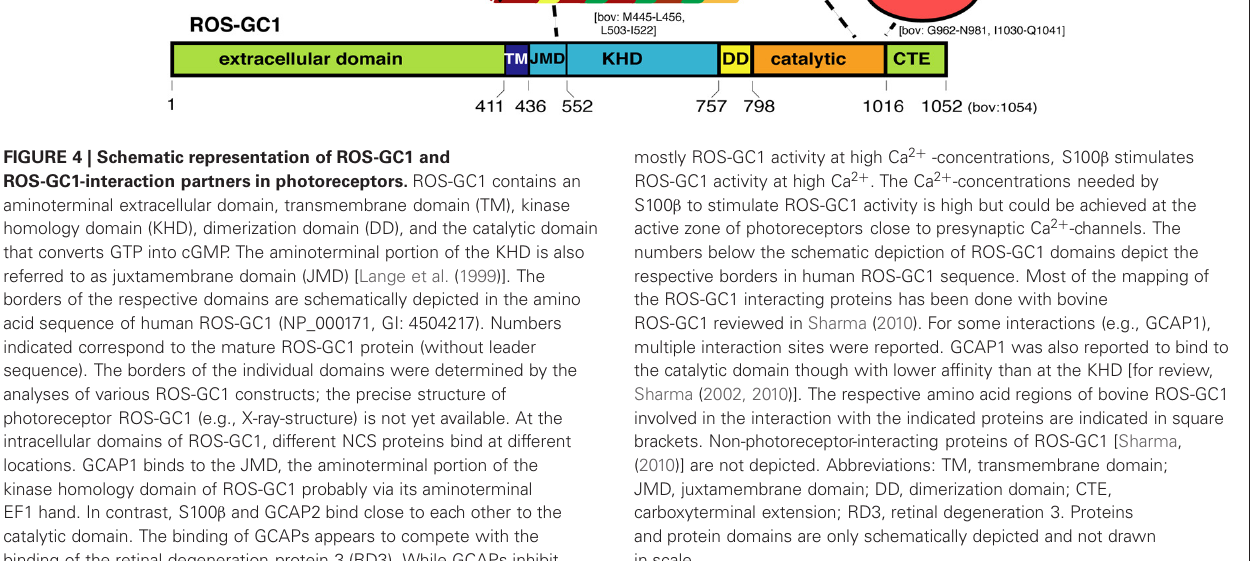
mostly ROS-GC1 activity at high Ca 2 + -concentrations, S100 β stimulates ROS-GC1 activity at high Ca 2 + . The Ca 2 + -concentrations needed by S100 β to stimulate ROS-GC1 activity is high but could be achieved at the active zone of photoreceptors close to presynaptic Ca 2 + -channels. The numbers below the schematic depiction of ROS-GC1 domains depict the respective borders in human ROS-GC1 sequence. Most of the mapping of the ROS-GC1 interacting proteins has been done with bovine ROS-GC1 reviewed in Sharma (2010). For some interactions (e.g., GCAP1), multiple interaction sites were reported. GCAP1 was also reported to bind to the catalytic domain though with lower affinity than at the KHD [for review, Sharma (2002, 2010)]. The respective amino acid regions of bovine ROS-GC1 involved in the interaction with the indicated proteins are indicated in square brackets. Non-photoreceptor-interacting proteins of ROS-GC1 [Sharma, (2010)] are not depicted. Abbreviations: TM, transmembrane domain; JMD, juxtamembrane domain; DD, dimerization domain; CTE, carboxyterminal extension; RD3, retinal degeneration 3. Proteins and protein domains are only schematically depicted and not drawn in